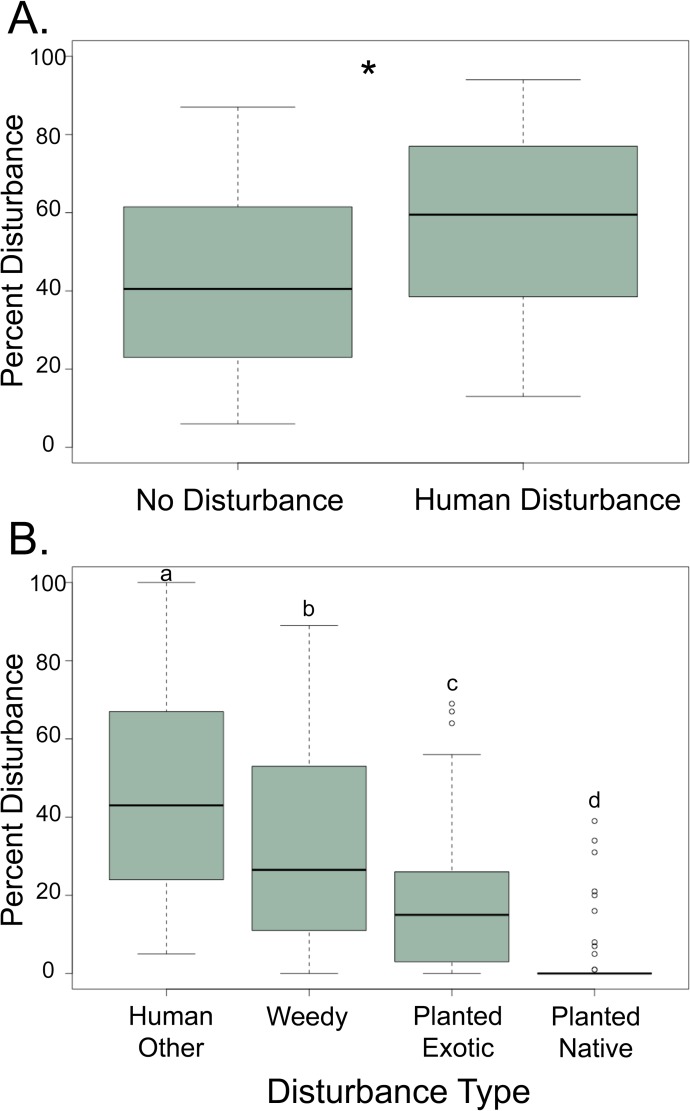
Human disturbance is pervasive across church forests.A. Box-and-whiskers plots of percent no disturbance and human disturbance across 44 church forests in northern Ethiopia. Asterisk indicates significant difference using a student’s t-test (t = 3.18, p = 0.002). B. Human disturbance types across church forests. Box-and-whisker plots of disturbance types in church forests. Lower case letters indicate significant differences among categories using a Tukey HSD, p < 0.05. The majority of disturbance in church forests is from direct human impacts followed by the proliferation of weedy species.